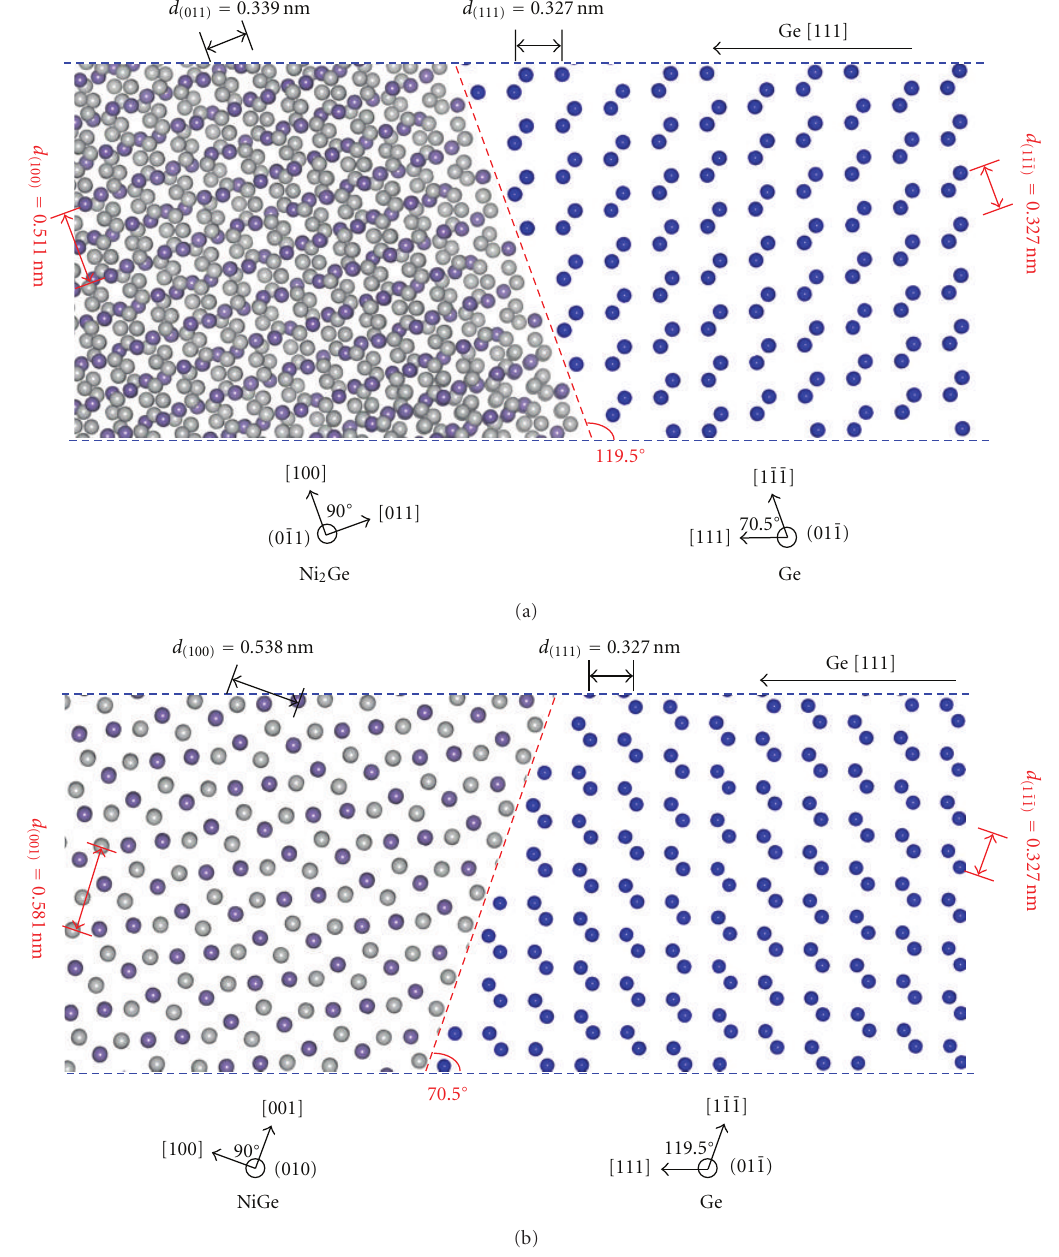
Figure 8: Schematic illustration of the epitaxial relationships of (a) the Ni 2 Ge/Ge interface in the Ni 2 Ge/Ge/Ni 2 Ge nanowire heterostructure and (b) the NiGe/Ge interface in the Ni 2 Ge/NiGe/Ge/NiGe/Ni 2 Ge nanowire heterostructure, respectively. Both of them show “twisted” but di ff erent growth modes. The grey and purple balls represent the Ni and Ge atoms in the Ni x Ge lattice, respectively, while the blue one represents the Ge atom in the Ge lattice. Reproduced from